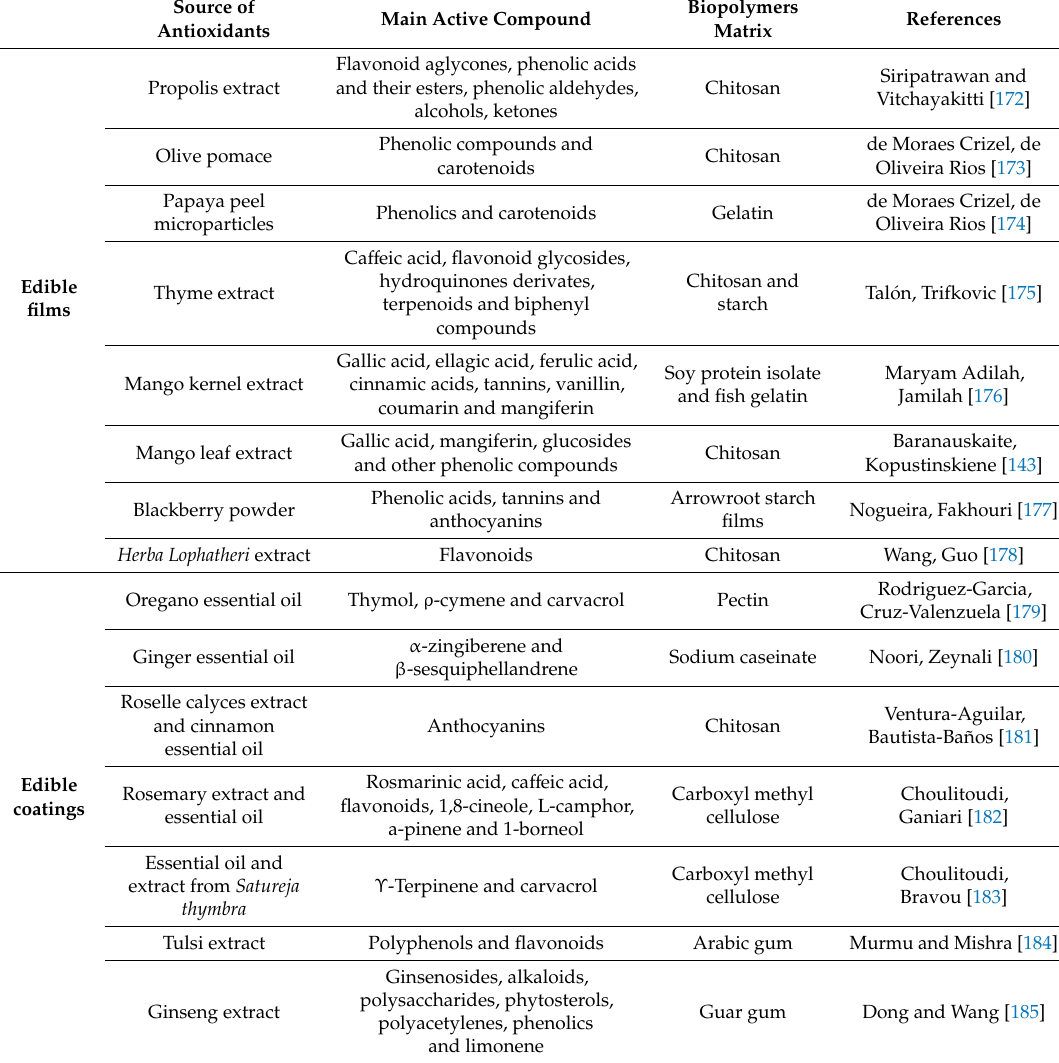
Table 5. Application of antioxidant-enriched edible films and edible coatings for food